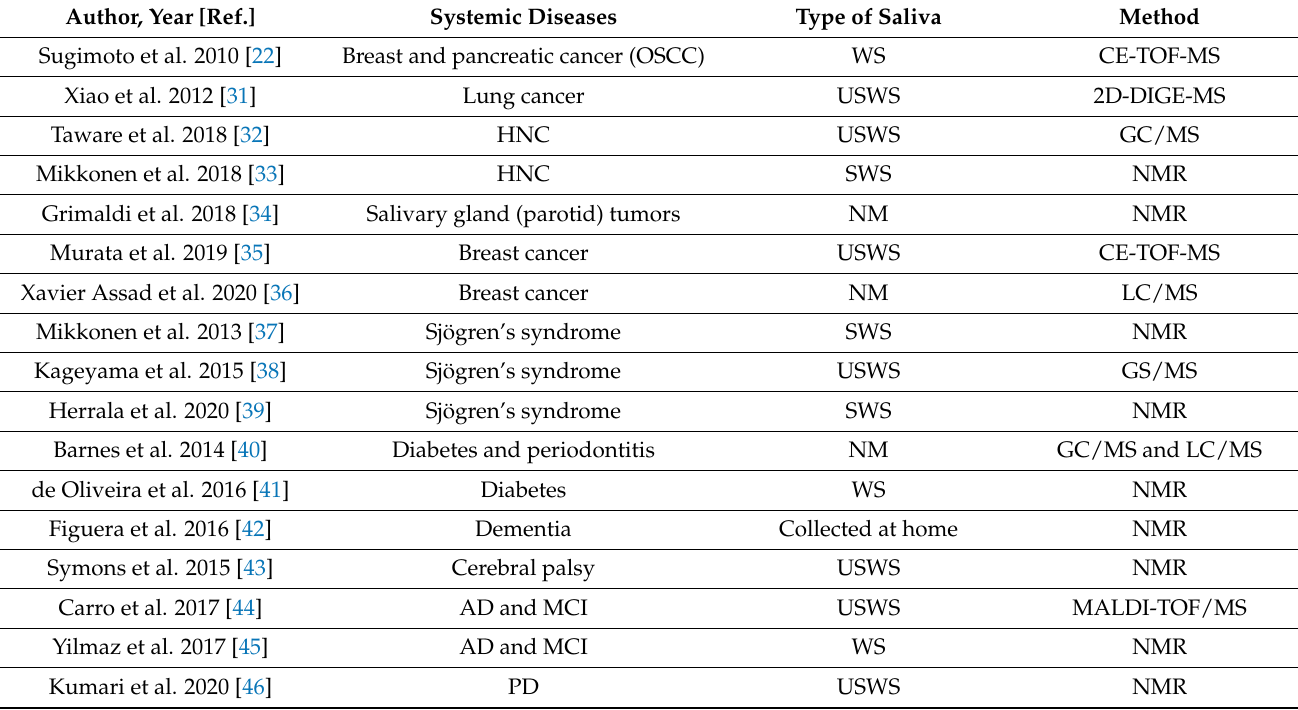
Table 2. A summary of studies investigating salivary metabolomics of systemic